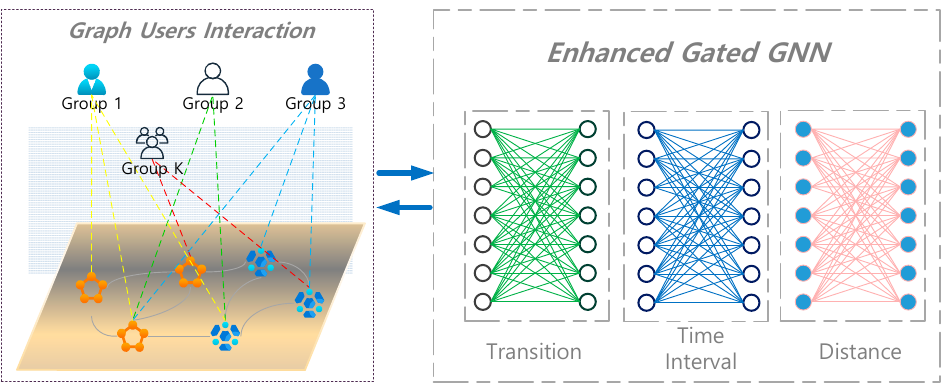
Figure 7. Deploying Gated GNN for graph users interaction.